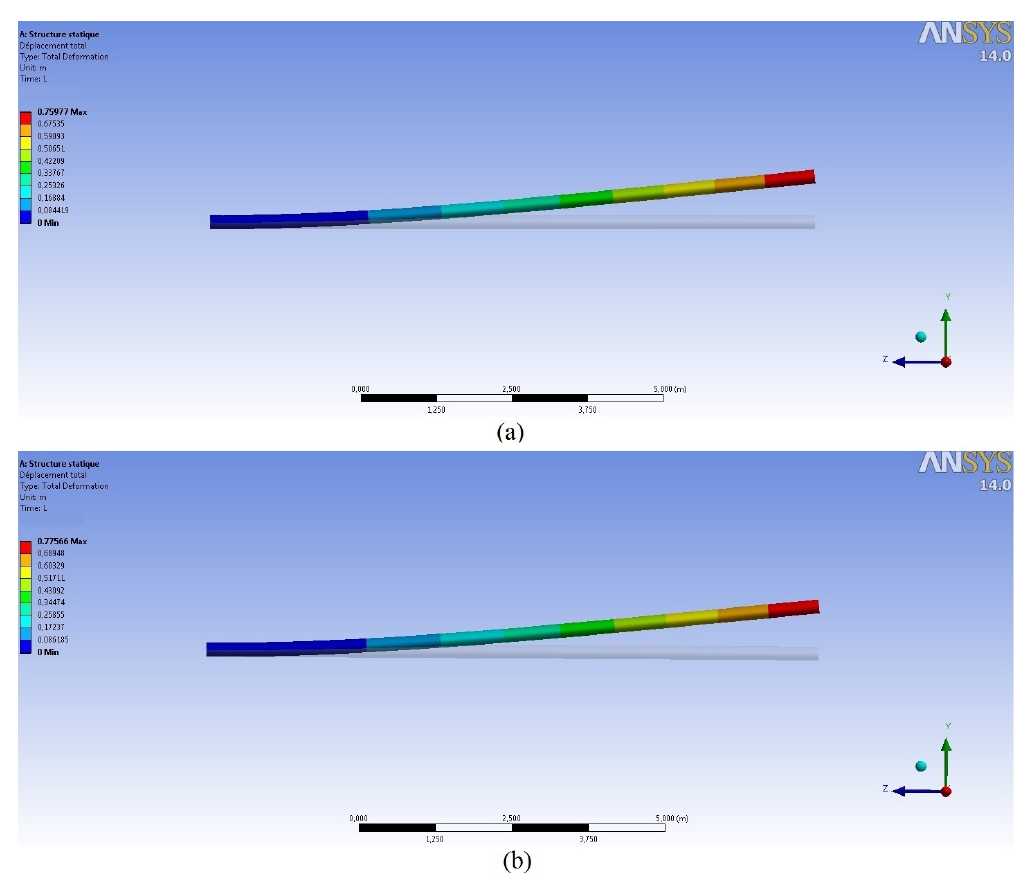
Figure 6. Total deformation of the wing: ( a ) one-way coupling; ( b ) two-way coupling.